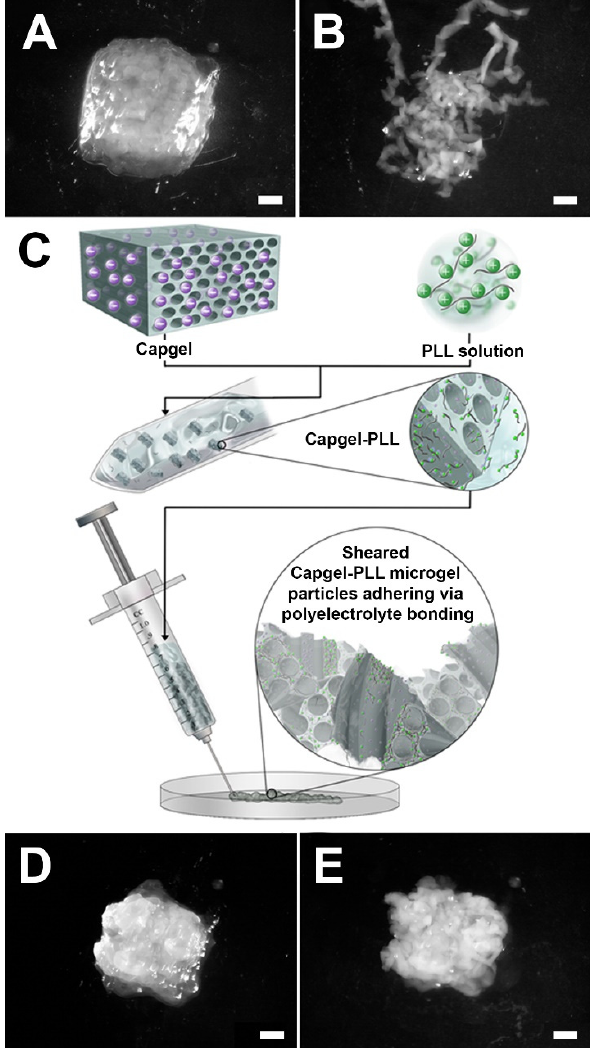
Figure 5. Capgel-PLL biomaterial ink self-adheres through shear-induced fragmentation followed by polyelectrolyte bonding. Capgel 25 G needle extrusions before ( A ) and after ( B ) submersion in saline; ( C ) illustration of the Shear-Induced Fragmentation Polyelectrolyte Bonding—SIFPeB— mechanism for Capgel-PLL self-adherence. Capgel-PLL 25 G needle extrusions before ( D ) and after ( E ) submersion in saline. Scale bar = 1 mm for all.